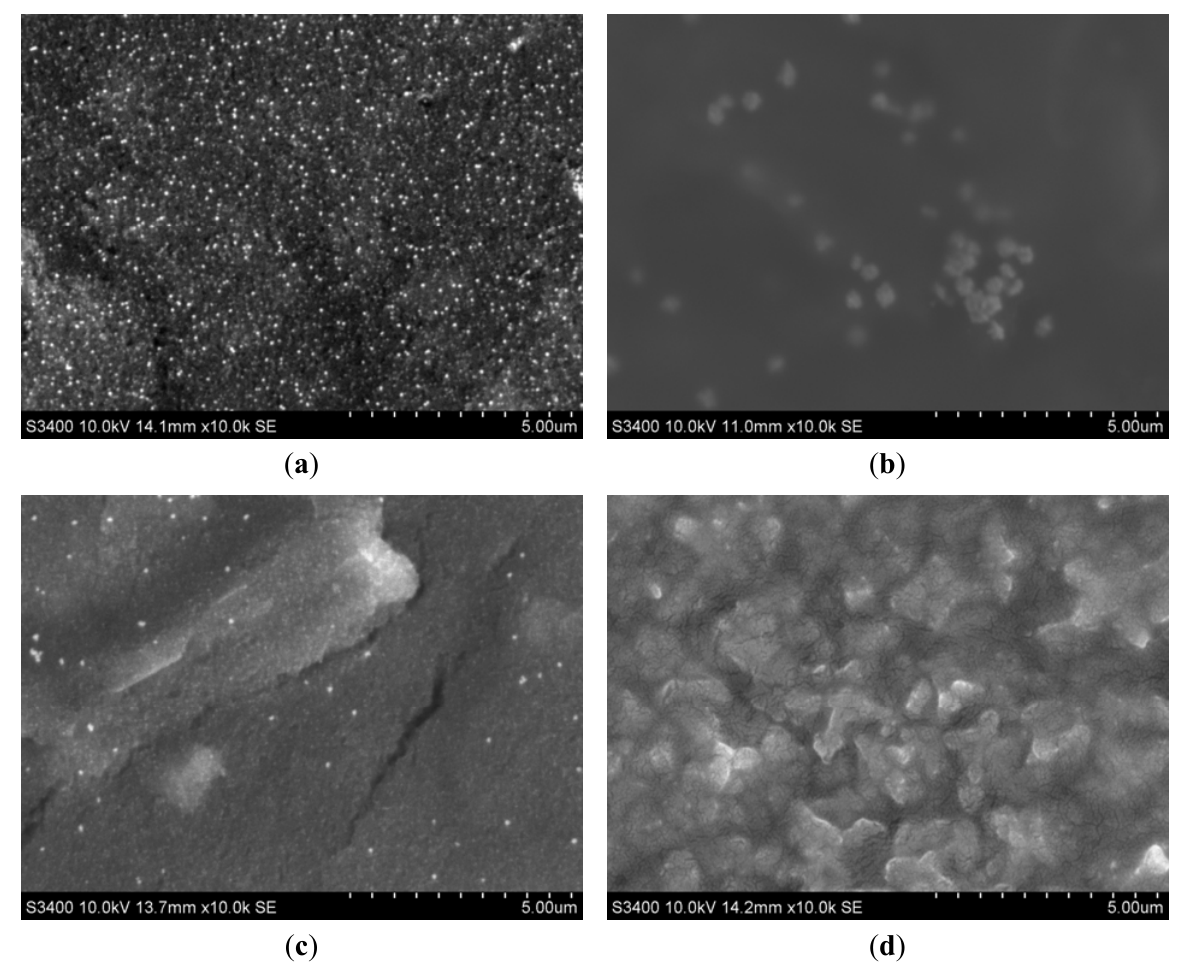
Figure 2. SEM images of ( a ) AuNPs/GE; ( b ) Thiolated protein G/AuNPs/GE; ( c ) AFP Ab1/thiolated protein G/AuNPs/GE; ( d ) Sandwich incubated with EVC-AFP Ab2.